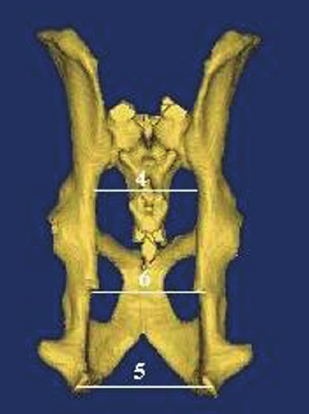
Figure 4: Measurements on facies dorsalis of pelvic cavity.